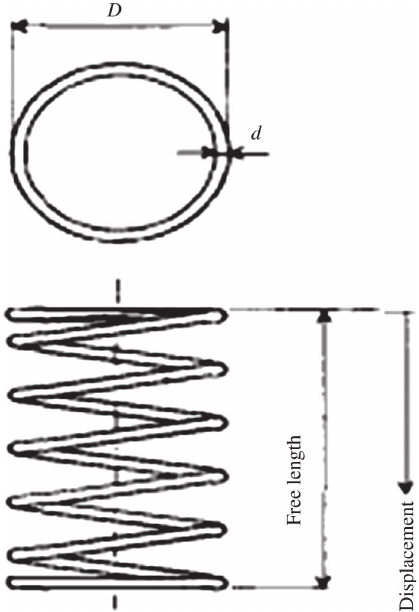
Figure 8: Design of Helical Spring